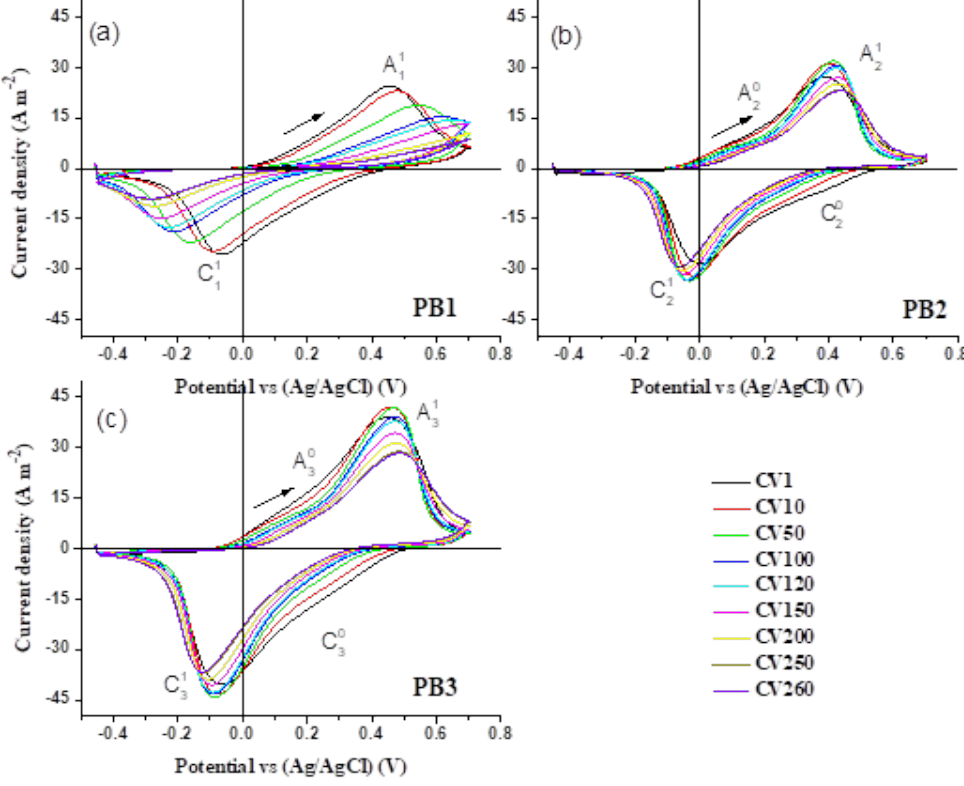
Figure 7. Cyclic voltammograms of the ( a ) PB1, ( b ) PB2 and ( c ) PB3 films, recorded in a solution containing 0.1 M HNO 3 and 0.1 M KNO 3 , at a scan rate of 100 mVs −1 .